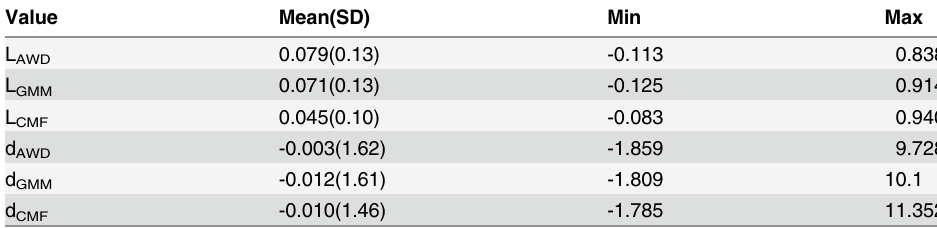
Table 1. The descried of LSBL and d i values for each breed